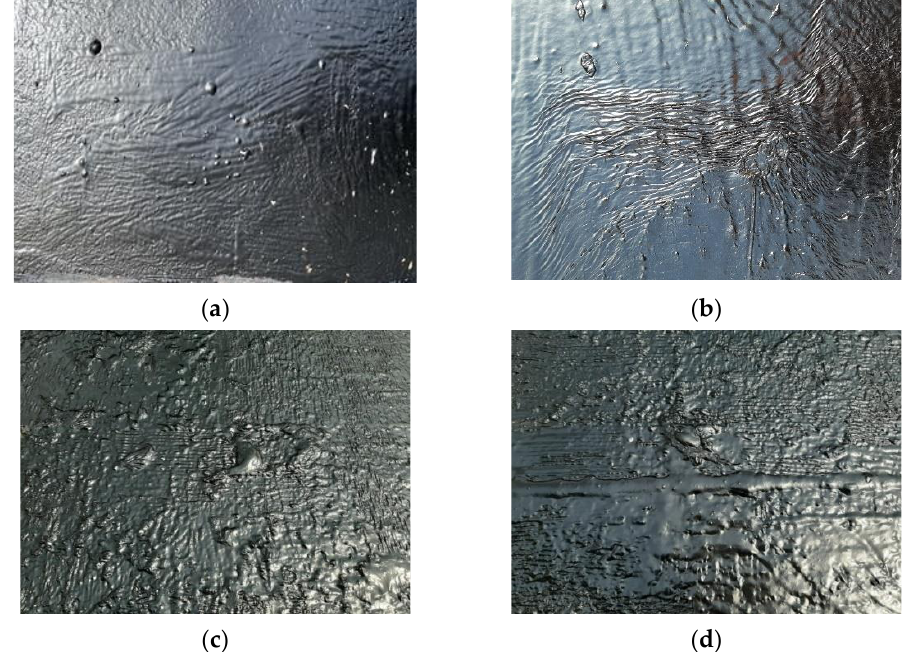
Figure 14. Mixing error in some items in nylon fiber 2.2% blend ratio. ( a ) Film thickness imbalance; ( b ) poor workability; ( c ) agglomeration of materials; ( d ) agglomeration of materials.